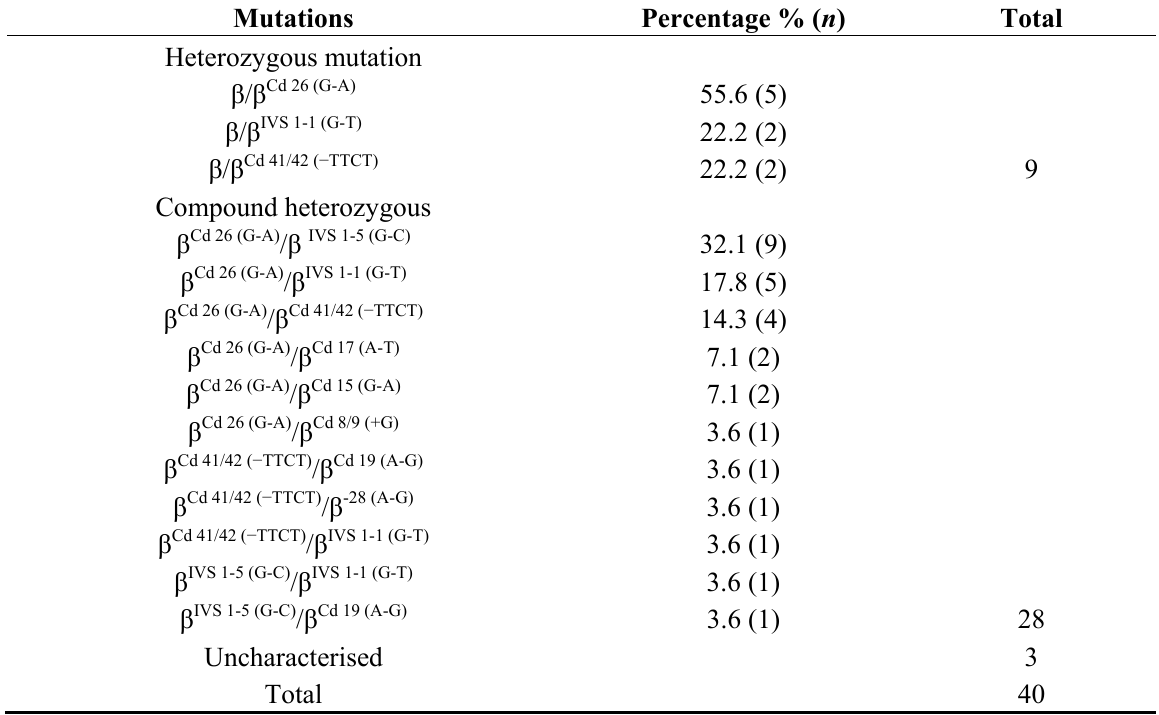
Table 3. Frequency of β -thalassaemia mutations identified in Malay patients using